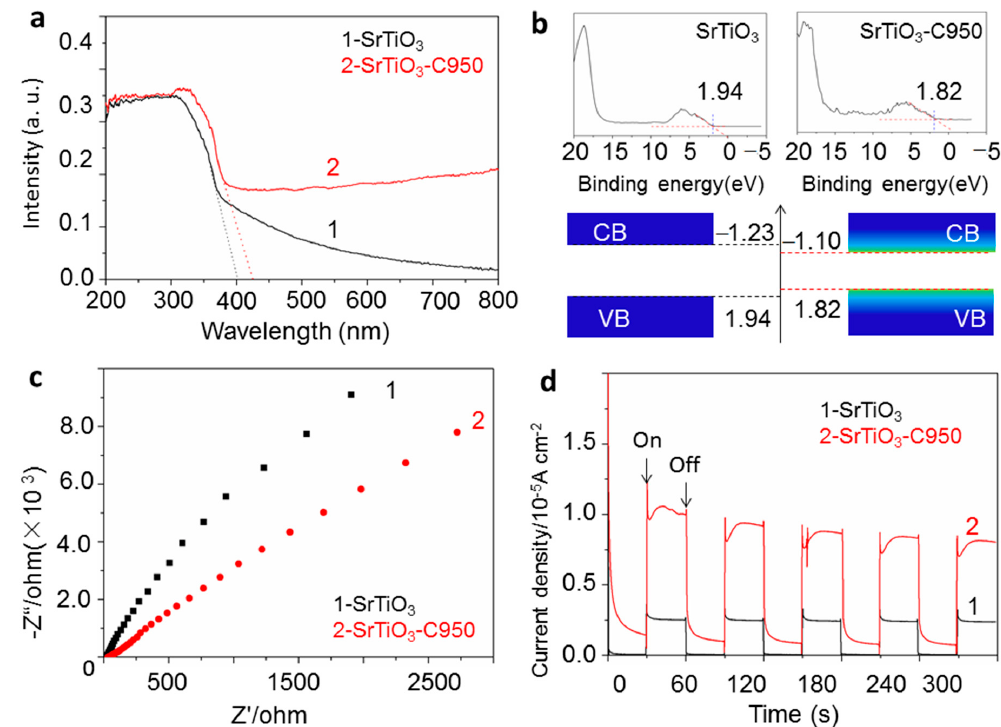
Figure 5. Ultraviolet–visible diffuse reflectance spectrum (UV-Vis DRS) ( a ), XPS Valence Band Spectrum and Energy band structure of SrTiO 3 (left) and SrTiO 3 -C950 (right) ( b ), Electrochemical impedance spectroscopy ( c ) and Photocurrent density ( d ) of SrTiO 3 -C950 and SrTiO 3 .